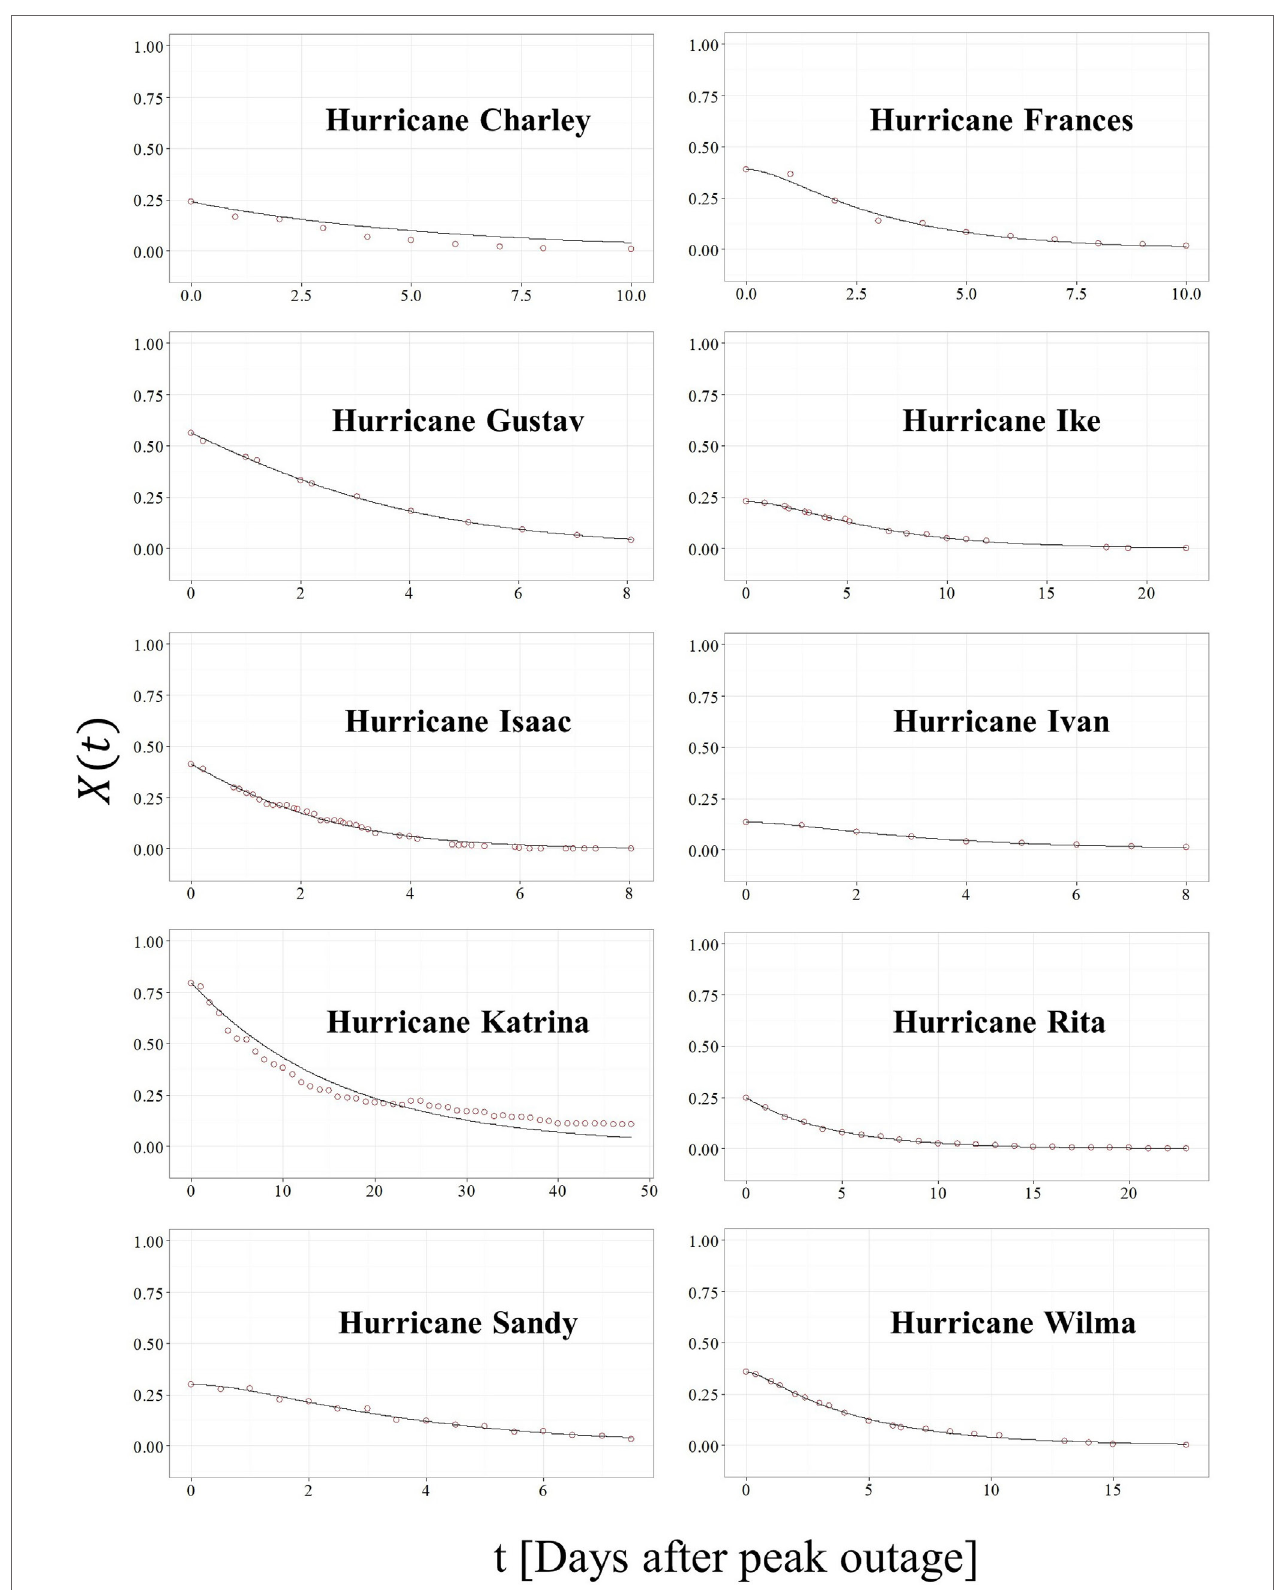
FigUre 5 | Inoperability X(t) fits for state level hurricane